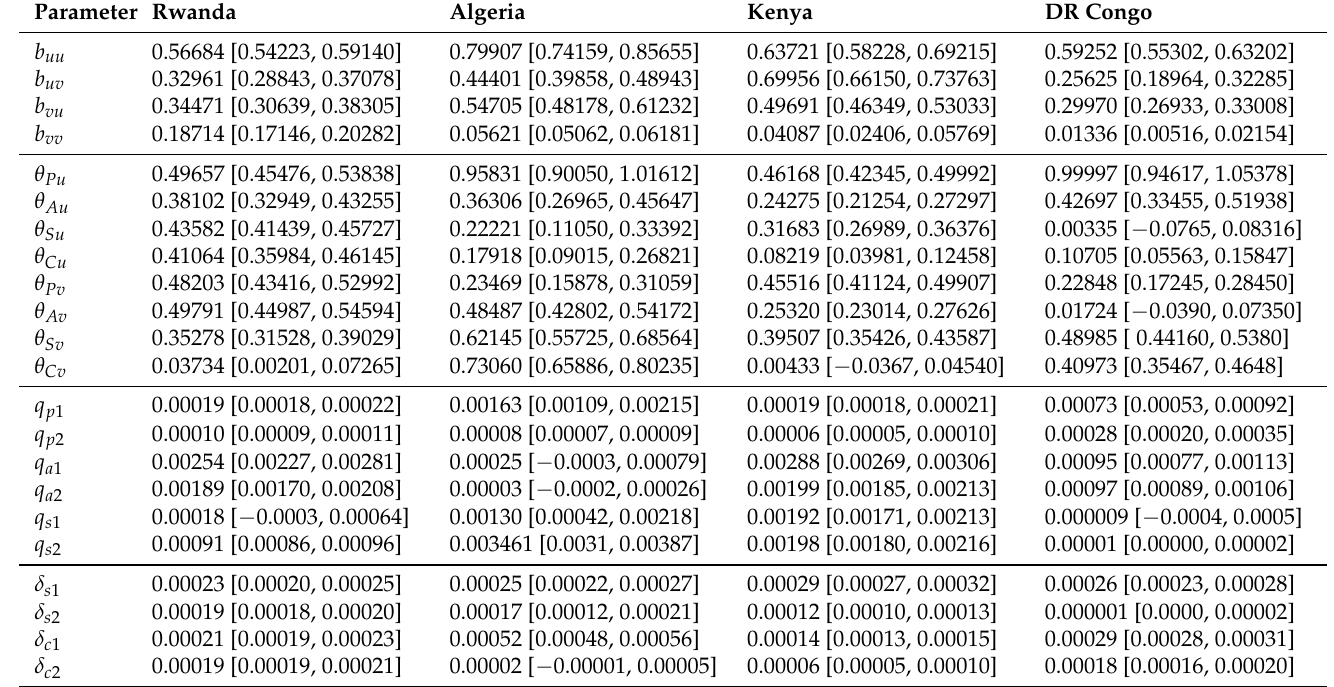
Table A6. Estimated parameter values and their 95% CI for the model for each selected country.